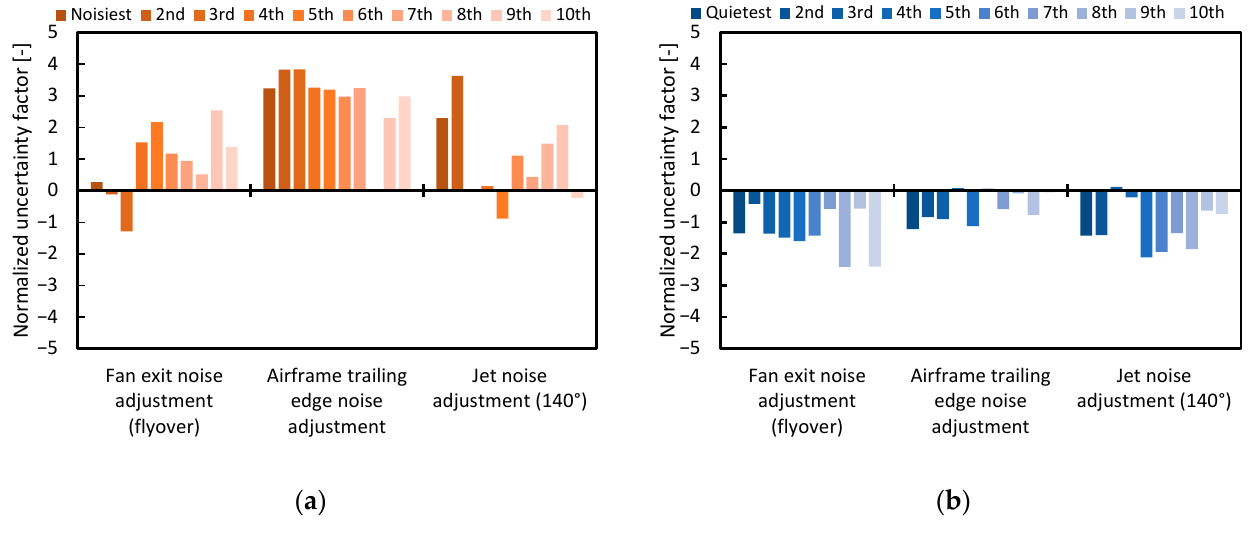
Figure 12. Normalized values of top three explanatory variables for: ( a ) the 10 cases with the loudest takeoff noise; ( b ) the 10 cases with the quietest takeoff noise.